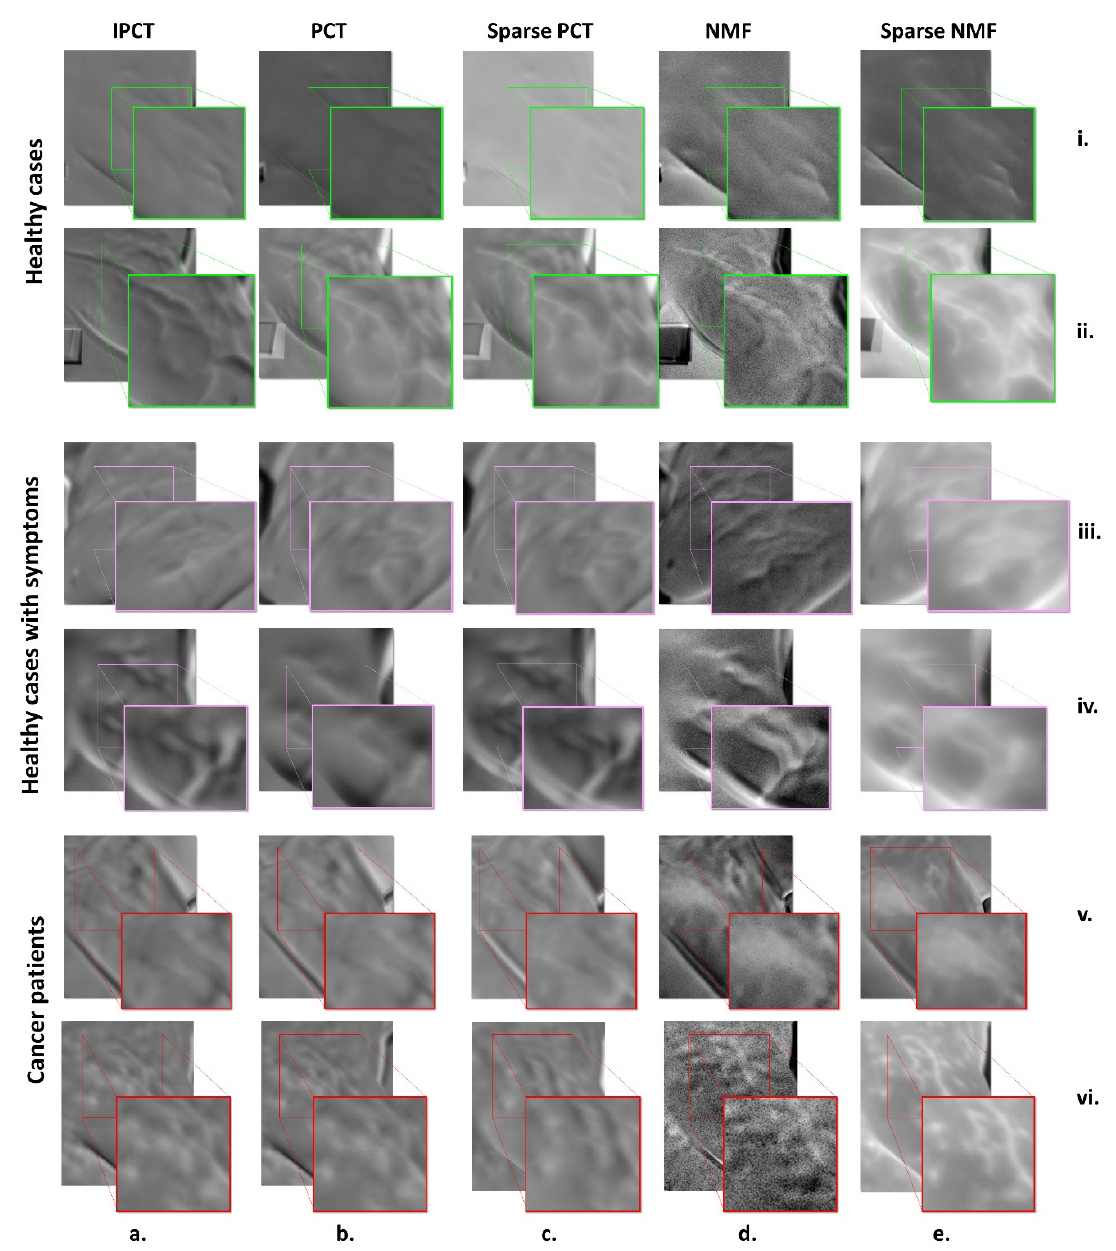
Figure 4. Some examples of low-rank thermal matrix approximation for six cases (healthy, healthy with symptoms, and symptomatic) using different matrix factorization techniques. ( i , ii ) The regions of interest (ROIs) of low-rank approximate representations of healthy cases. ( iii ) A healthy case with pain and changes in the nipple of the patient. ( iv ) Case in which a patient experienced pain in the breast and the results of the biopsy indicated a noncancerous lesion. ( v , vi ) Cases representing cancer patients. Their columns show low-rank thermal matrix representation for the targeted ROI. Columns ( a – e ) represent the matrix factorization techniques used to extract the low-rank representation IPCT, PCT, Sparse PCT, NMF, and Sparse NMF, respectively.